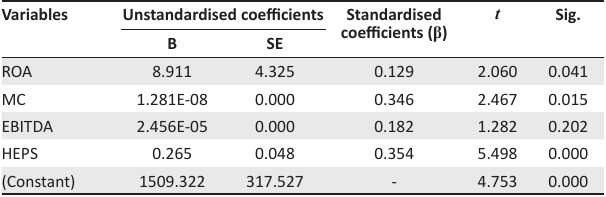
TABLE 5: Regression coefficients – Fixed pay. Variables